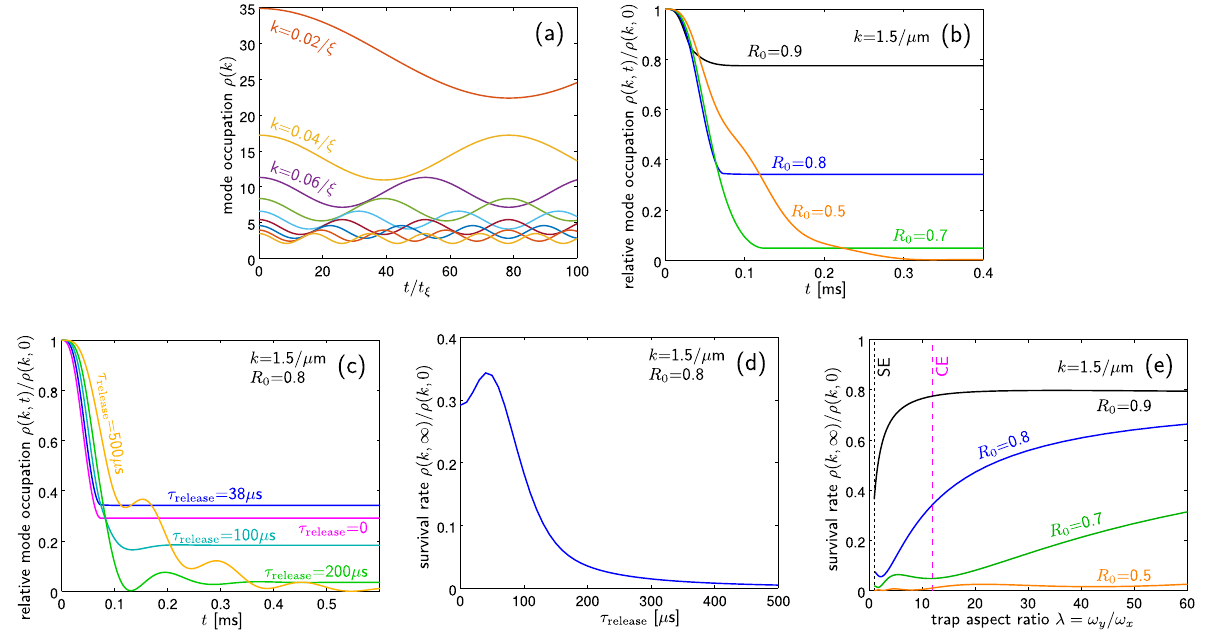
k modes in a uniform gas initially in the Bogoliubov Figure 4. Toy model simulations for k and − ground state. ( a ) Behaviour after a “caricature” quench to half-density, as per Eq. (16) for modes with k ξ 0.02, 0.04, . . . , 0.18 . The remaining panels concern the better toy model of Eqs. (S10, S17) with parameters = 902 895 71 Hz, N 455852 , n 0 43.66 / µ m 3 peak density, and like the full simulation with ω = × × = = τ release 38 µ s , and show the mode occupation evolution relative to the initial value (the survival rate). ( b ) For = ( 1 /ω y ) y / R 2 gn 0 / m , different initial locations in the condensate in the narrow direction: R 0 where R = ⊥ ⊥ = 1.5 / µ m . ( c ) Evolution of the relative occupation for different ramp speeds τ release . Cycles and initial k (cid:31) = of reabsorption are seen for the slow ramps. ( d ) Final survival rate for the same parameters. ( e ) Shows the dependence of the final survival rate on the trap aspect ratio (cid:31) , when initial central density n 0 is kept constant. 12 (like CE simulations), the black dashed line a The magenta dashed line indicates the experimental (cid:31) = 1 (like SE spherical trap (cid:31) =